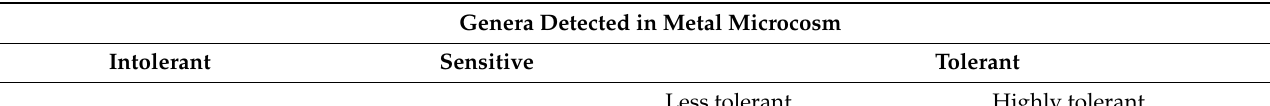
Table 4. Categories of bacterial indicator genera (sensitive, tolerant, intolerant) in the metal micro- cosms of wetland sites 1, 2, 3, and